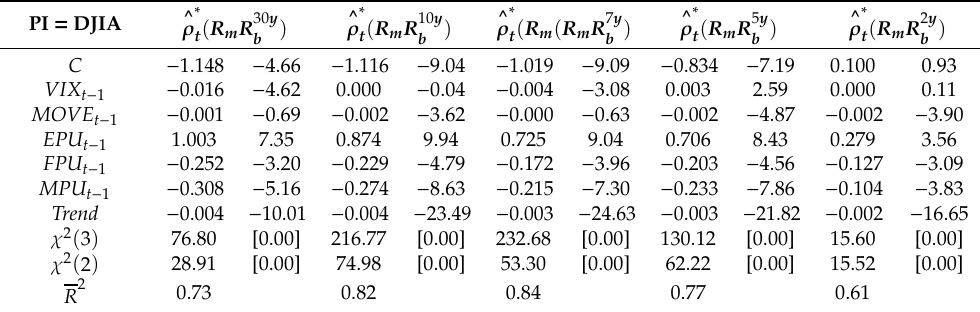
Table 5. Estimates of aggregate and categorical EPU, FPU, and MPU and on stock (DJIA)–bond return correlations.